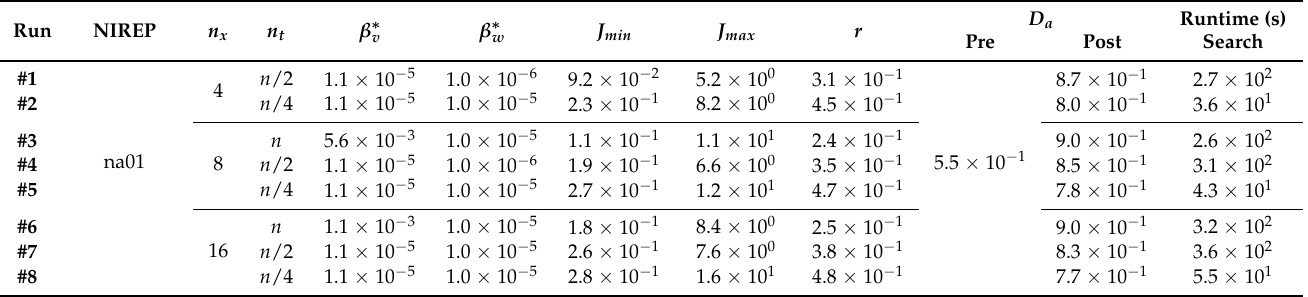
Table 8. Experiment 2B: Registration performance for CLAIRE for case 2 ( n t independent of the image resolution) . Comparison of registration accuracy using Dice and relative residual r for a fixed number of time steps n t at different resolutions for the registration of the real MRI datasets MRI250 and the reference image m 1 generated from na01 from the NIREP repository. We consider three resolution levels n x = { n , n /2, n /4 } where n = ( 640,880,880 ) . We fix the tolerance for the relative gradient to 5 × 10 − 2 . We use linear interpolation in the semi Lagrangian schreme. The bounds for the determinant of the deformation gradient for the parameter search are [ 0.05,20 ] . We keep the time step n t fixed. We report the regularization parameters β ∗ v and β ∗ w obtained through the proposed parameter search scheme, the minimum and maximum determinant of the deformation gradient ( J min and J max ), the relative residual ( r ), the average Dice ( D a ), pre and post the registration, as well as the wall clock time for the parameter search. The case with n x = n and n t = 4 failed to finish in under 4